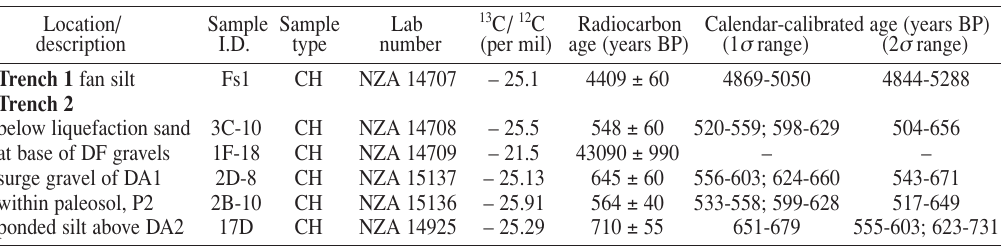
Table I. Summary of radiocarbon dating results from the Greenburn trenches, Eastern Hope Fault. Location/